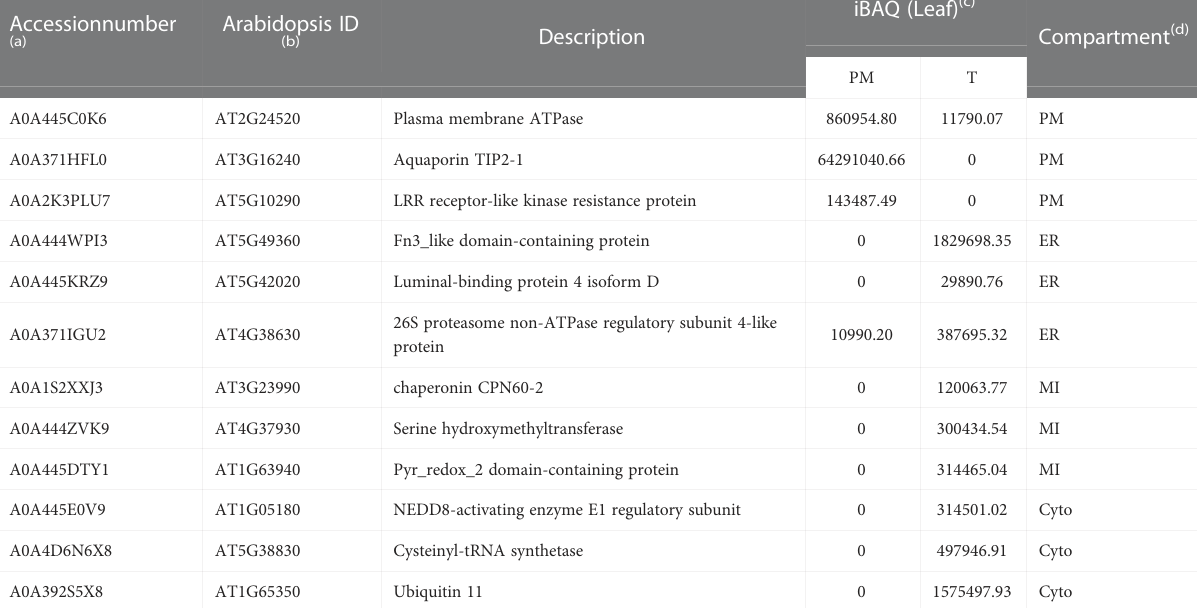
Accessionnumber (a)